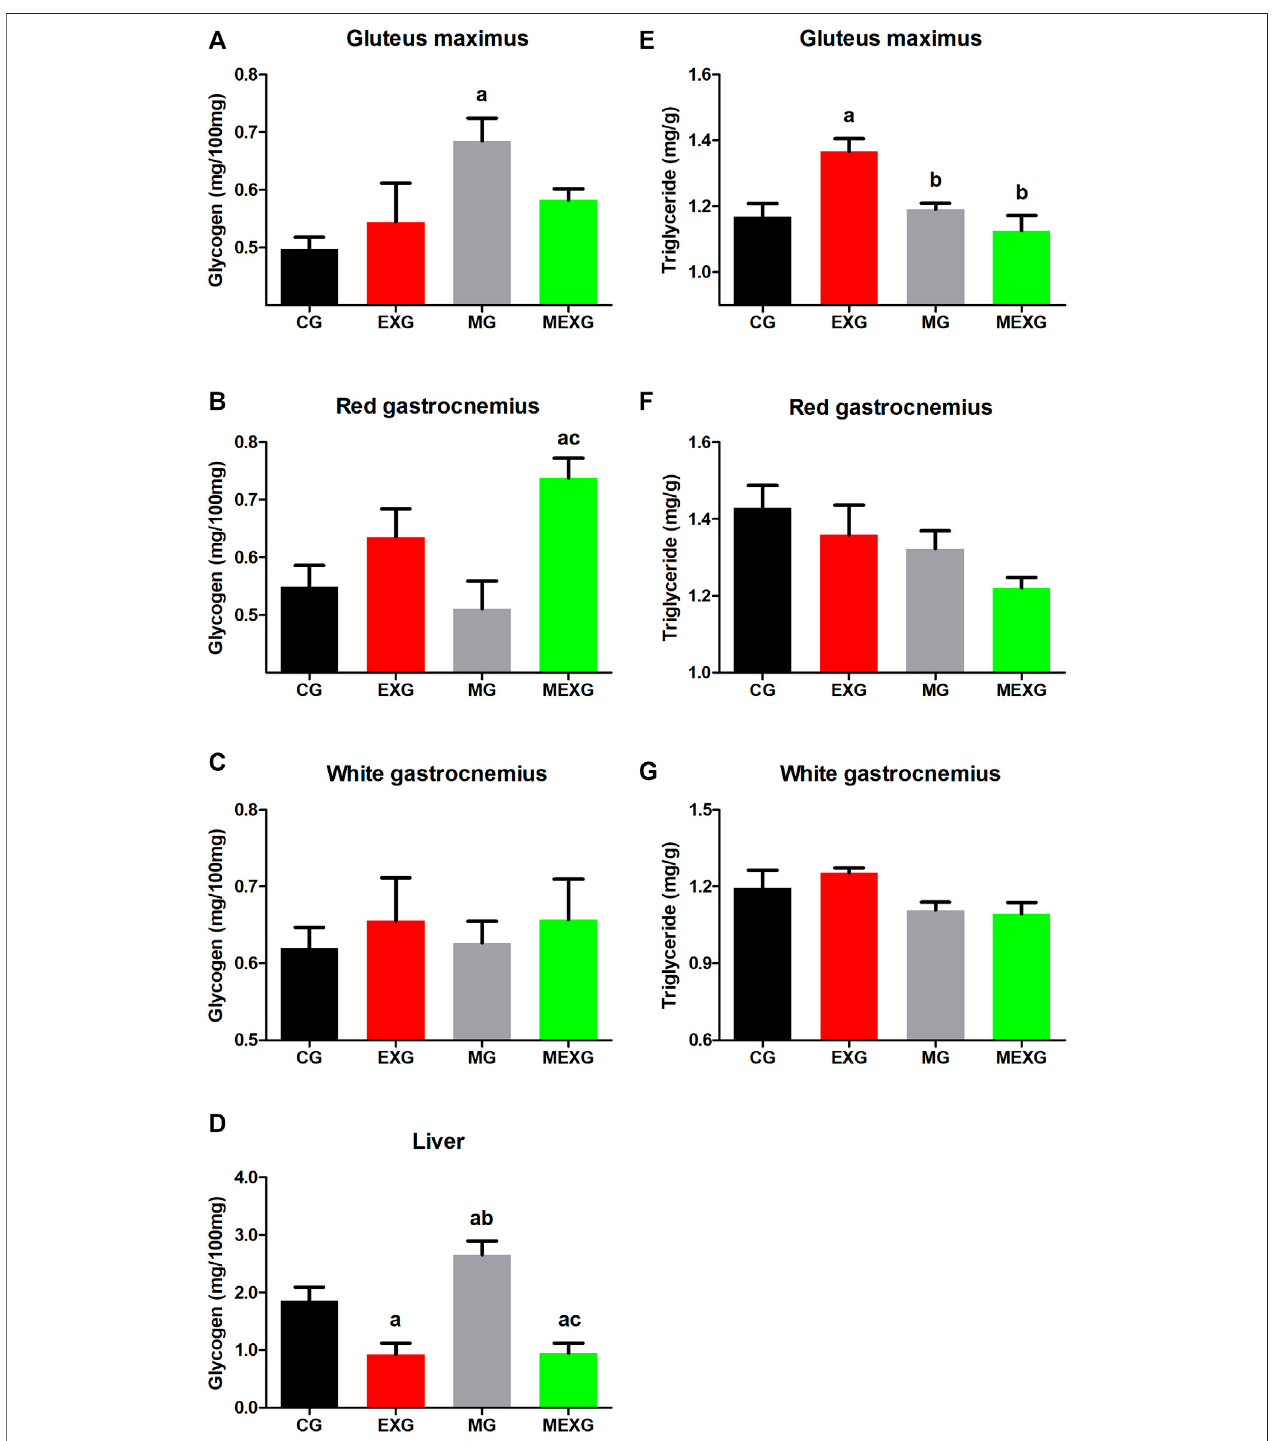
FIGURE3| Glycogencontentinskeletalmusclesandliver,andtriglyceridecontentinskeletalmuscles.Thegraphsrepresentthemeansandstandarderrorsofthe glycogen content in the gluteus maximus (A) , red (B) and white (C) gastrocnemius and liver (D) , and triglyceride content in gluteus maximus (E) , red (F) and white (G) gastrocnemiusincontrolrats(CG),ratstreatedwithmelatonin(MG),ratssubmittedtoexercise(EXG),andratstreatedwithmelatoninandsubmittedtoexercise(MEXG). a p < 0.05 with respect to CG; b p < 0.05 with respect to EXG; c p < 0.05 with respect to MG for the same parameter. mg, milligrams; g, grams; min, minutes.